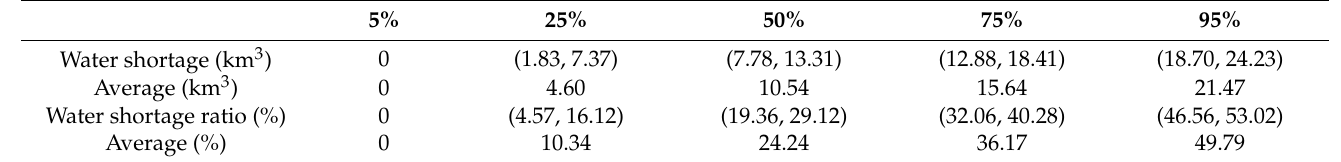
Table 9. Water shortage (Type I) under different guaranteed rates.